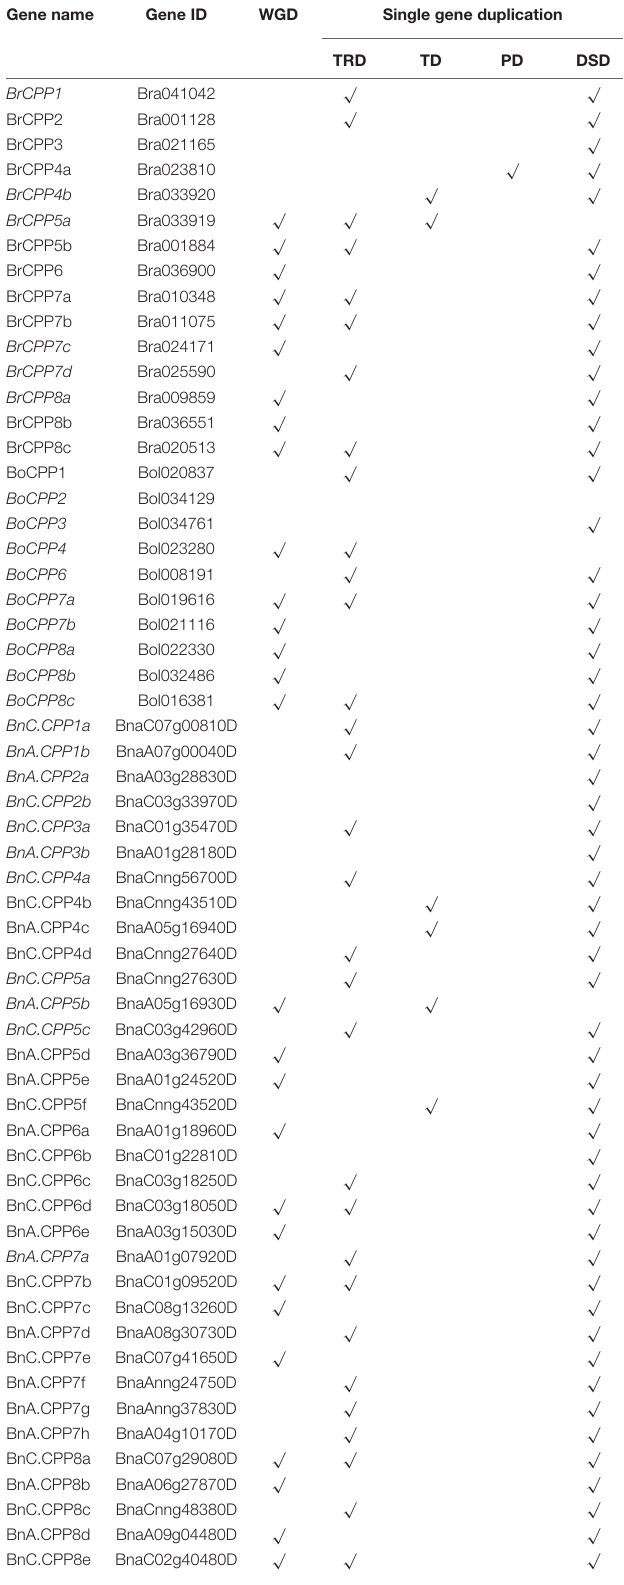
TABLE 2 | Five modes of CPP gene duplication in B. napus and its diploid